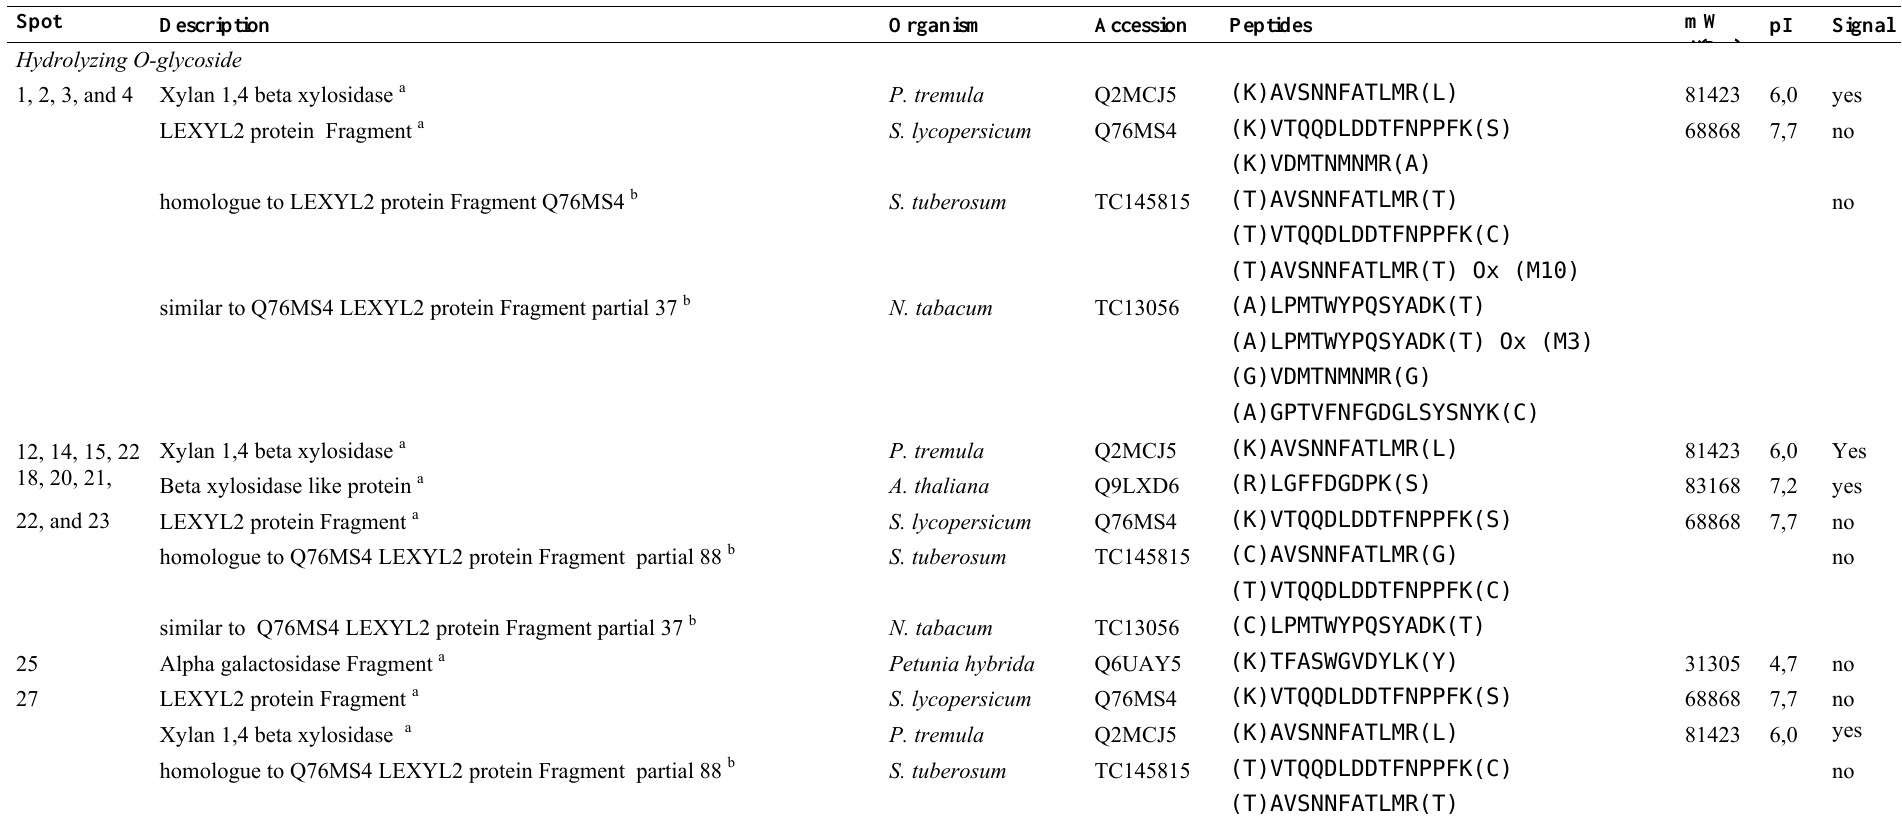
Table 1. Identification of secreted proteins from 2-DE analysis of culture medium. Identified proteins together with the corresponding organism, accession number, peptides, theoretical isoelectric point (pI), molecular weight (Mw), and annotation of signal peptides are listed. Molecular weight and pI were not available for identified EST-clones. When, database searches lead to the identification of the same protein for several spots data were summarized. Individual databases are indicated as a) TREMBL, b) TIGR and c) Swissprot. Annotations for signal peptide were estimated from N-terminal sequences (70 aa) with SignalP 3.0 (http://www.cbs.dtu.dk/services/SignalP) and the